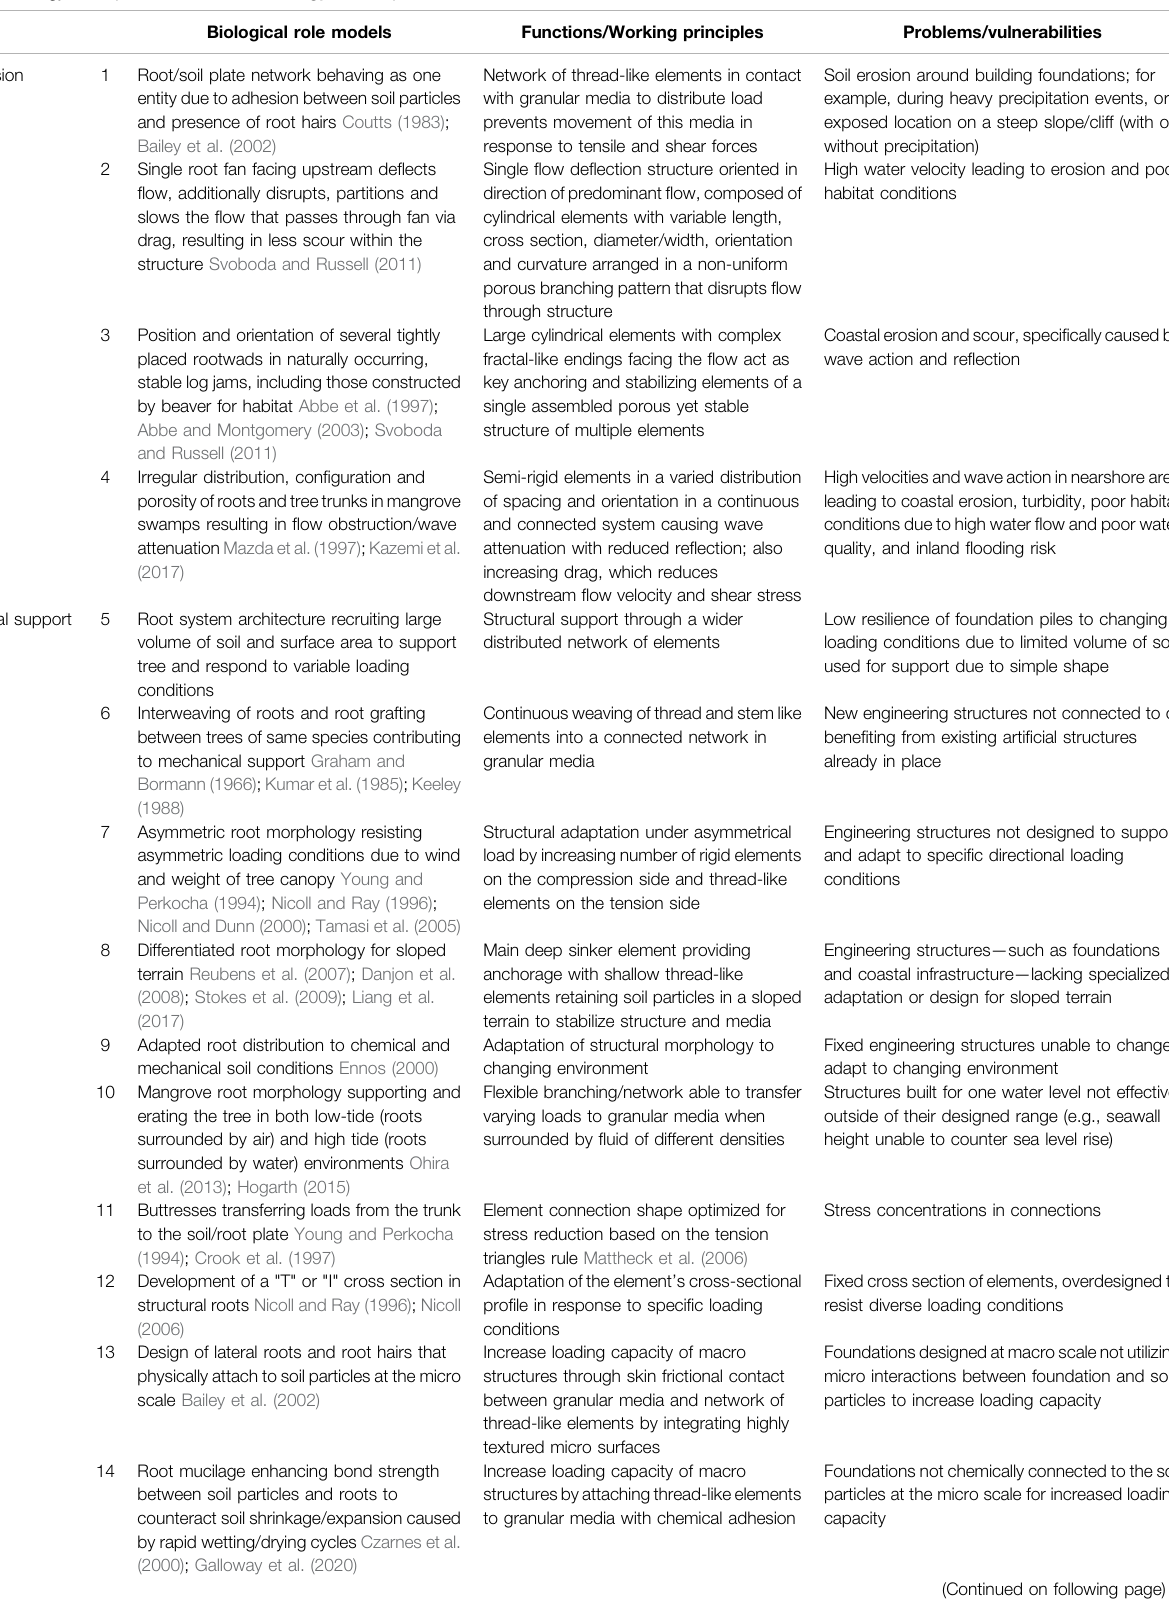
TABLE 1 | Analogy table ( “ Abstraction and Analogy ” section). Biological role models Functions/Working principles